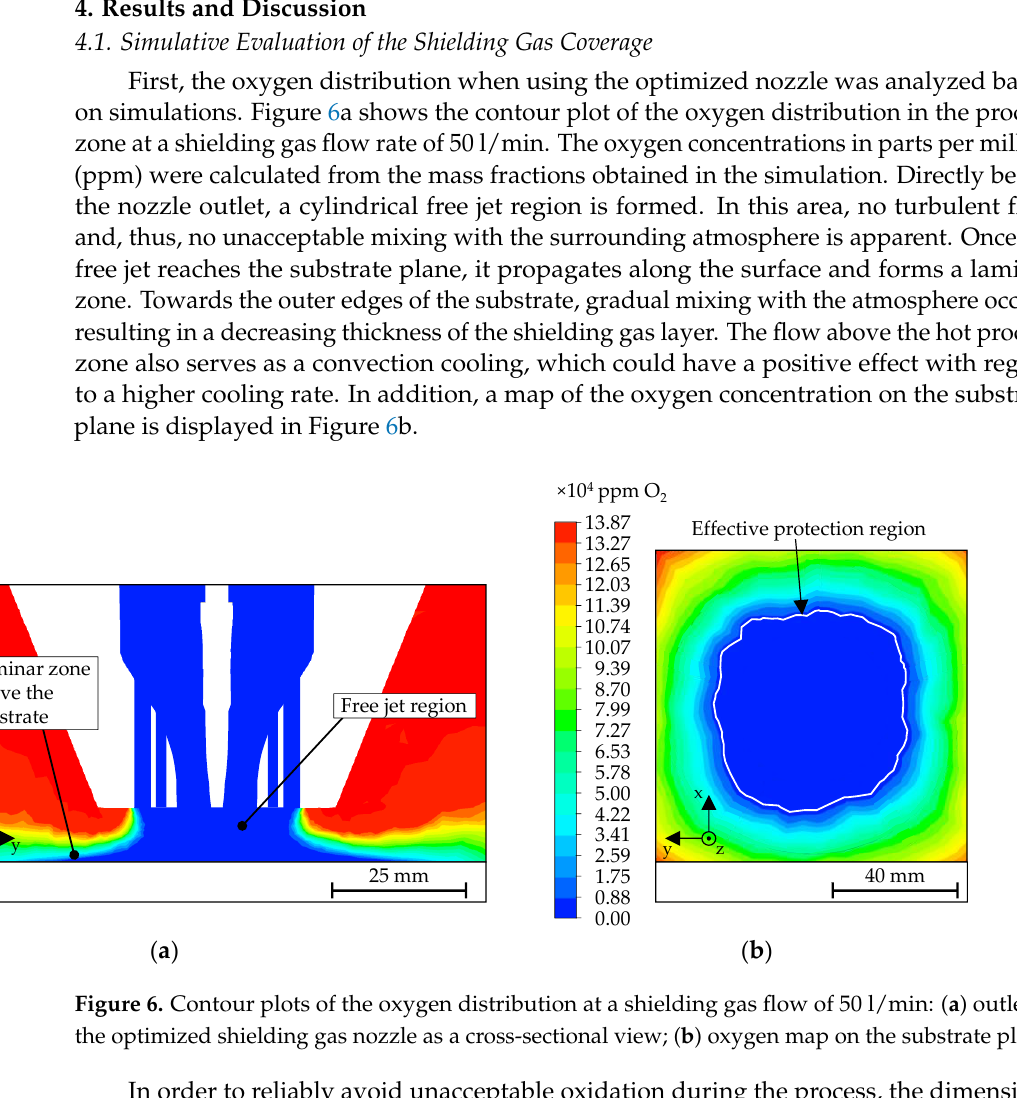
area. Between 5 l/min and 40 l/min, the effective protection length increases rapidly from 0 mm to 65.9 mm. In contrast, a further increase of the flow rate from 40 l/min to 100 l/min results in only a 2.7 % increase of the effective protection length. Figure 7. Effect of the shielding gas flow rate on the effective protection length (indicated by the blue markers) on the substrate plane at a stand-off distance of 10 mm obtained from the simulations.